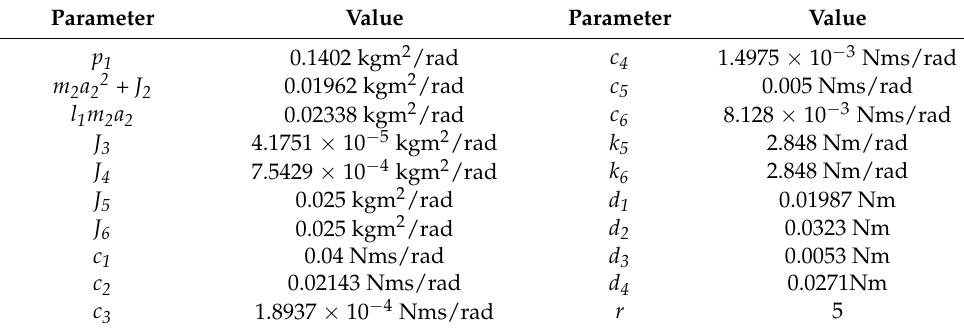
Table 1. Estimated Values of the Robot’s Physical Parameters [31]. Parameter